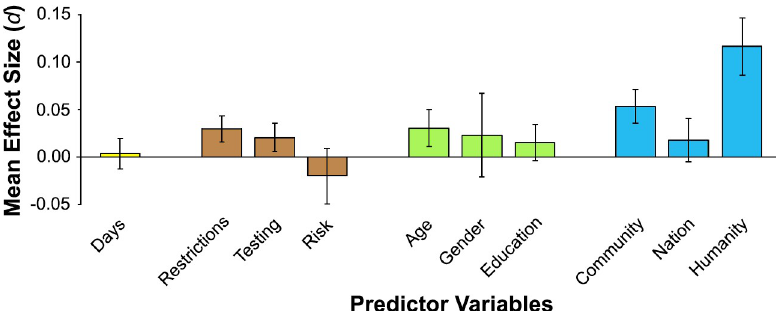
Fig 1. Mean effect sizes (estimated Cohen’s d ) across five outcomes for each predictor variable. The predictors are grouped into five classes (indicated by color): time/days since survey start (yellow), contextual factors (brown), respondent demographic characteristics (green), two psychological identification variables and our hypothesized predictor of identification with all humanity (blue). Positive values indicate that the predictor is associated with higher outcome scores. Error bars represent the standard error of the mean effect